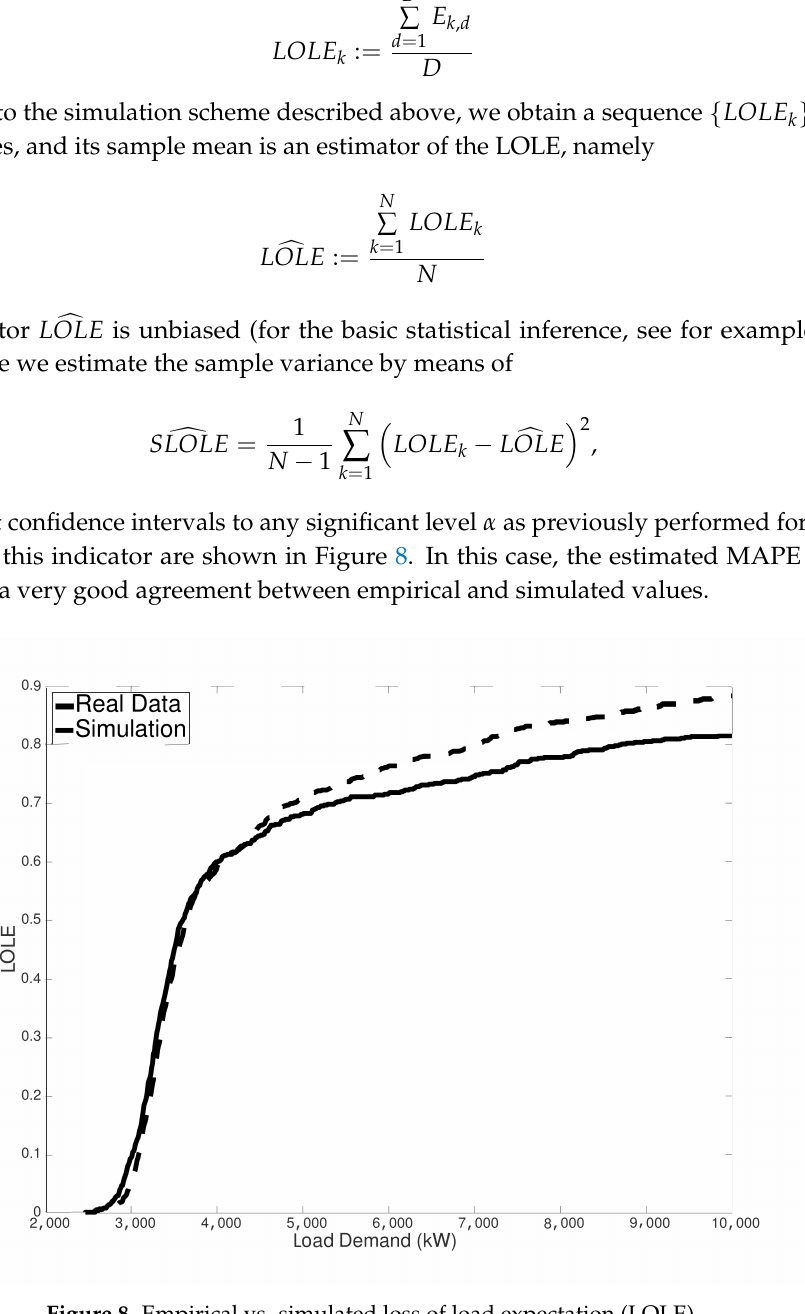
Figure 8. Empirical vs. simulated loss of load expectation